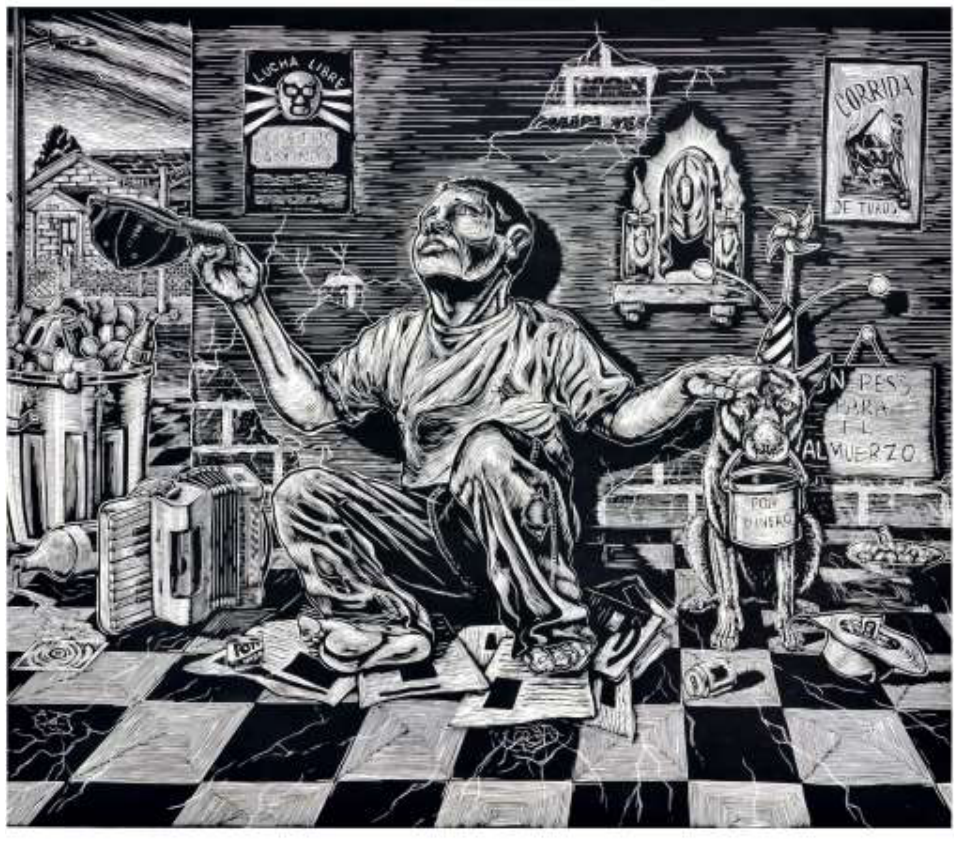
Juan de Dios Mora, A Coin for Breakfast , 2010, linocut, 26 x 27 ¼